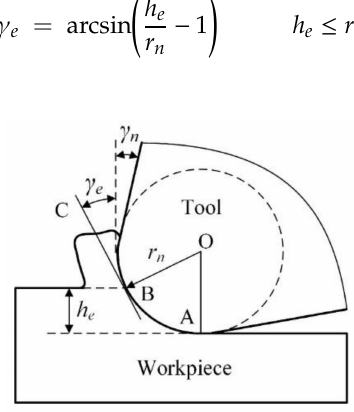
Figure 1. Schematic of e ff ective rake